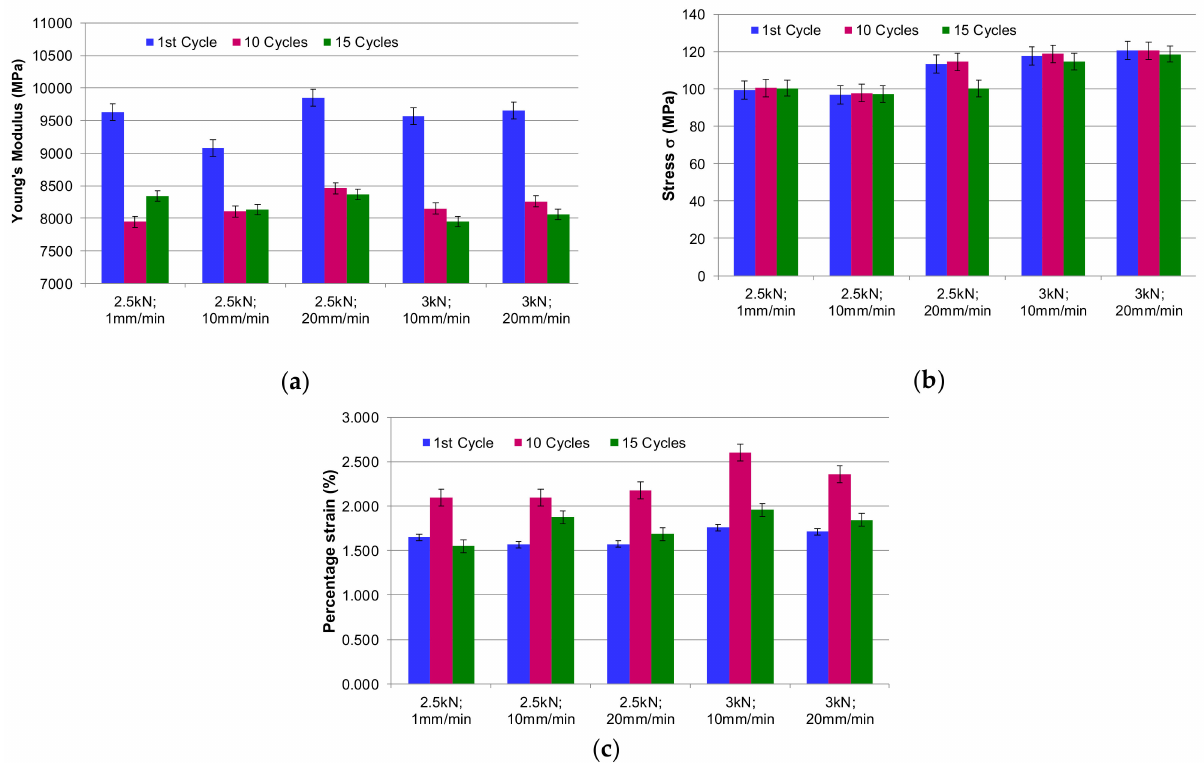
Figure 7. The mechanical properties obtained after tensile-tensile test: ( a ) values of Young’s modulus after different cycles; ( b ) variation of stresses; ( c ) variation of percentage